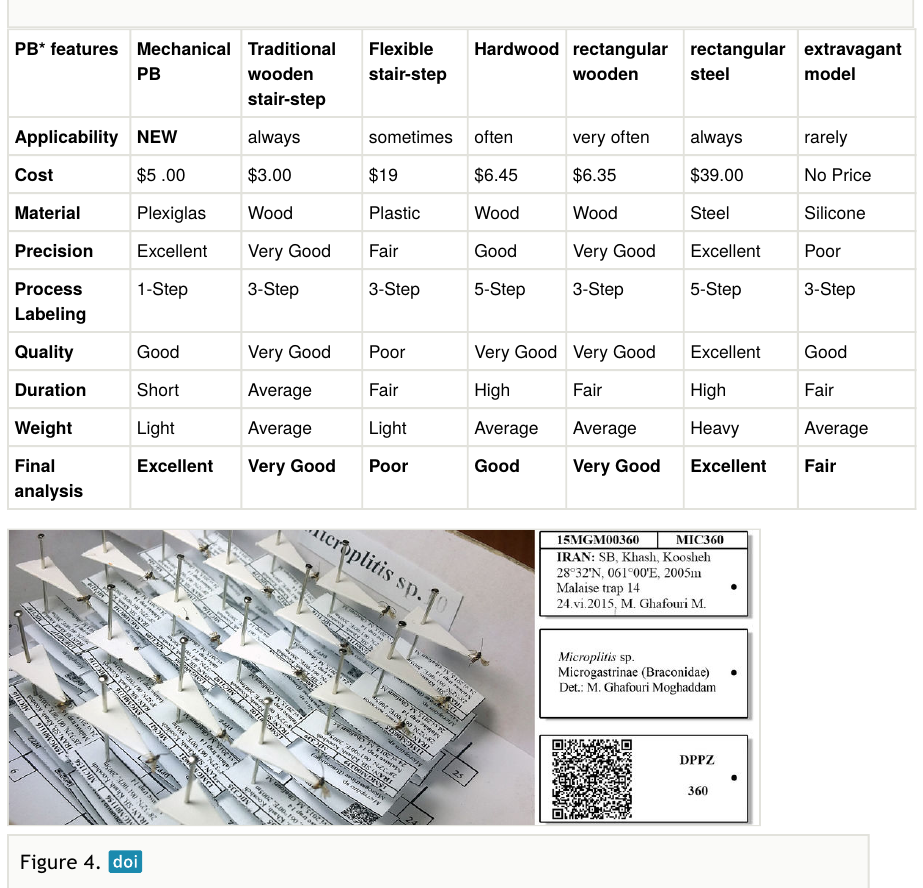
Table 1. Comparison of the important features of available pinning block on the market.